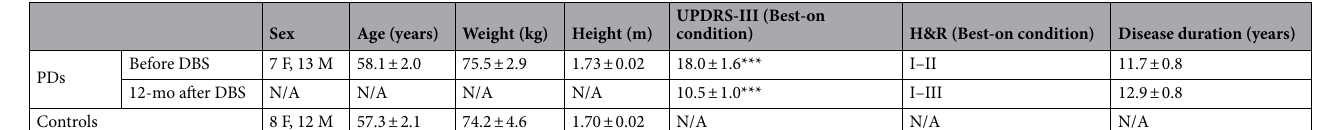
Sex Age (years) Weight (kg) Height (m)